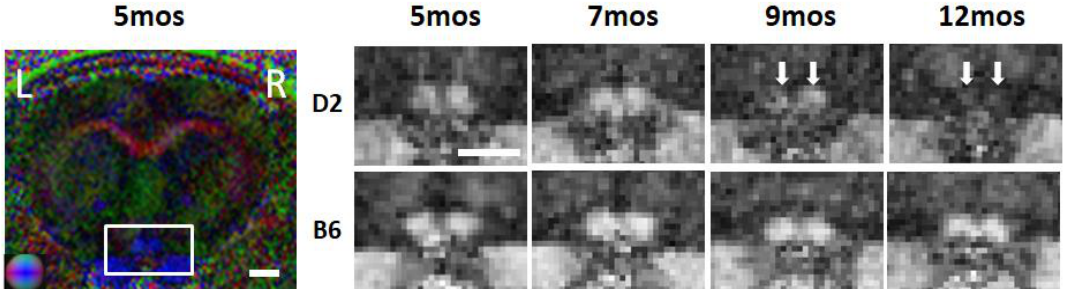
Figure 5. Longitudinal DTI at the level of the optic nerve (white rectangle) in the DBA/2J experi- mental glaucoma mouse model (D2) and healthy C57BL/6J mice (B6). ( Left ) Color-coded fractional anisotropy (FA) directionality map along caudal-rostral (blue), left-right (red), and dorsal–ventral (green) directions in a D2 mouse at 5 months old (mos). ( Right ) FA value maps of the D2 and B6 optic nerves from 5 to 12 mos. White arrows point to the deteriorating D2 optic nerves at 9 and 12 mos when intraocular pressure increased alongside the same period. Image adapted with permission from Yang et al. [12].